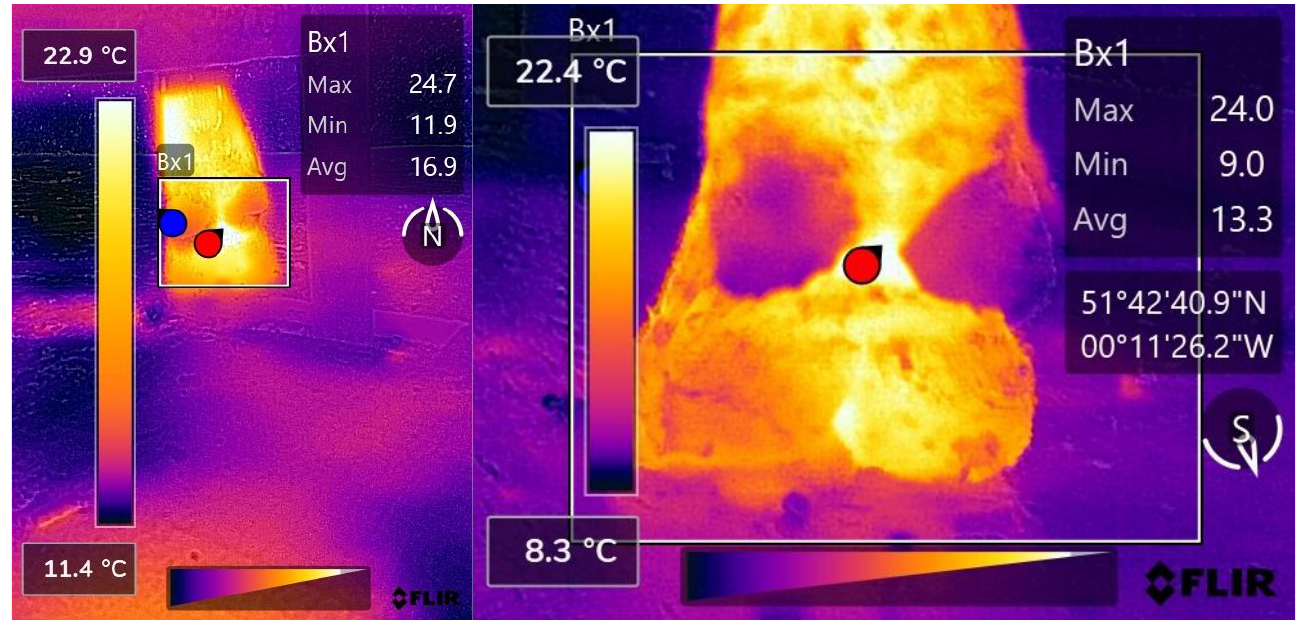
Figure 2. ( Left ) A thermogram captured by the CAT s62 Pro Smartphone and processed with FLIR Thermal Studios showing the point of maximum temperature within Bx1, labelled by the red marker, recorded as being caudal to the heel-bulbs on the medial side of the medial claw. The maximum temperature value transferred for statistical analysis from this thermogram was 24.7 ◦ C. ( Right ) A thermogram captured by the FLIR T620bx and processed with FLIR Thermal Studios showing the point of maximum temperature within Bx1, labelled by the red marker between the heel bulbs. The maximum temperature value transferred for statistical analysis from this thermogram was 24.0 °C.